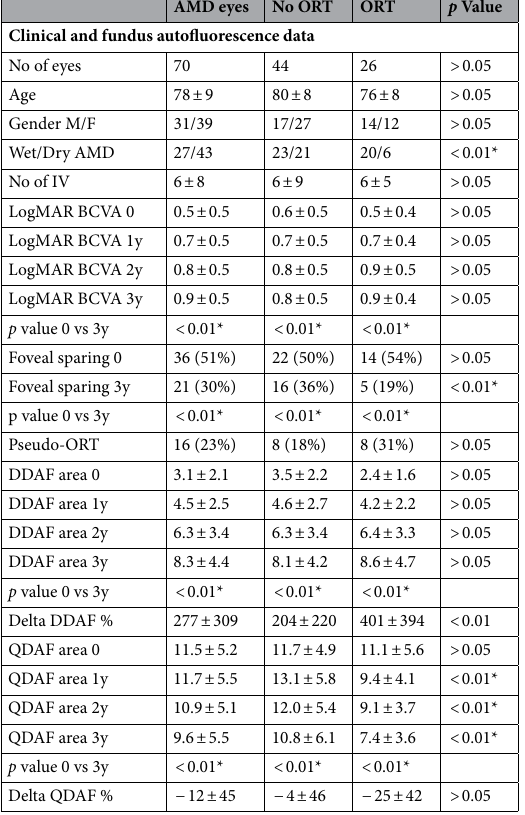
Table 1. Clinical and fundus autofluorescence data. Statistically significant p values are further highlighted by asterisks. The following abbreviations are used: intravitreal injections (IV), outer retinal tubulations (ORT), age-related macular degeneration (AMD), best corrected visual acuity (BCVA), definitely decreased autofluorescence (DDAF) area, questionably decreased autofluorescence (QDAF)